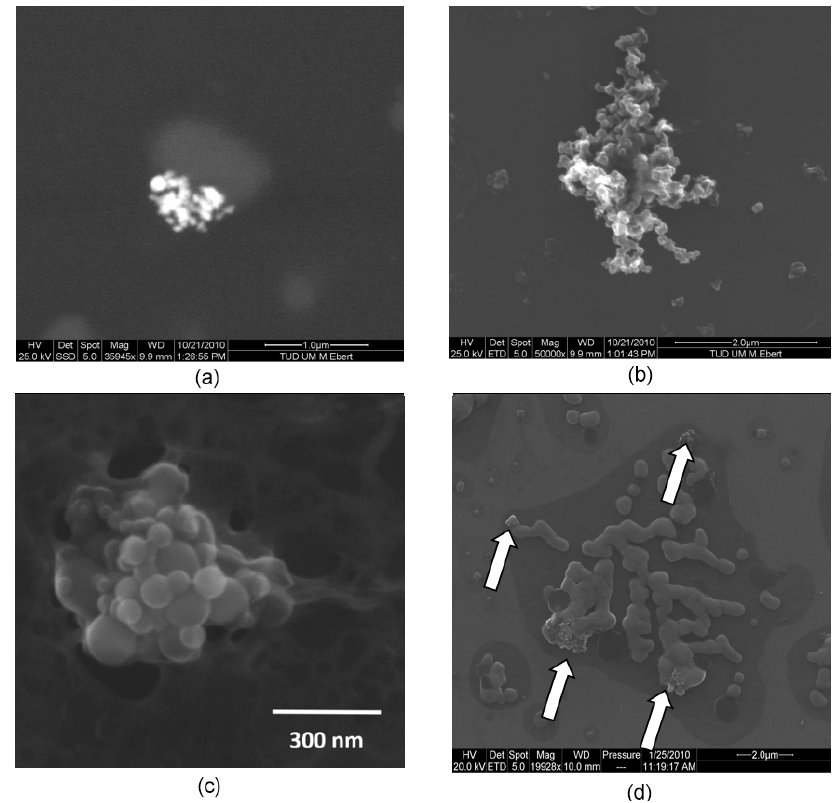
Figure 6. Secondary electron images of refractory particles in the fine fraction: (a) lead-rich agglomerate (bright) within a secondary particle; (b) soot particle; (c) agglomerate of spherical silicate particles; (d) soot inclusions (marked by arrows) within volatile